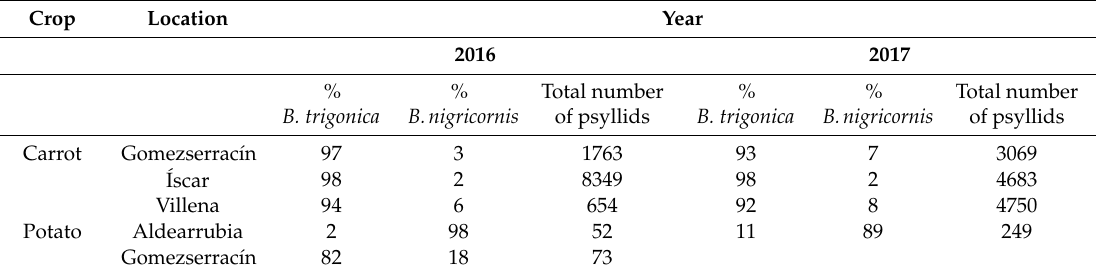
Table 3. Percentage of psyllid species found by sweep net sampling in carrot and potato fields surveyed in 2016 and